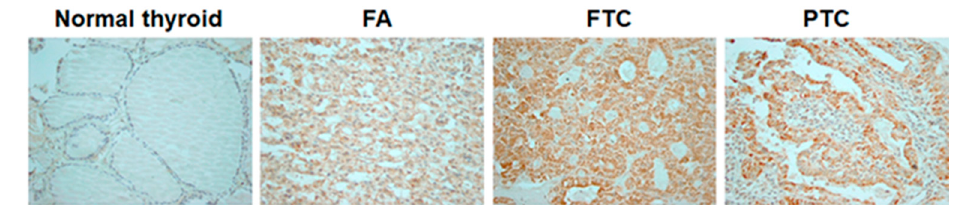
Figure 1. COX4 expression in human thyroid tissue samples. Immunostaining with anti-COX4 indicating minimal expression of COX4 in normal tissue samples, compared with the moderate expression in follicular adenoma (FA), and strong, homogeneous cytoplasmic expression in follicular thyroid cancer (FTC) and papillary thyroid cancer (PTC) (magnification ×400).